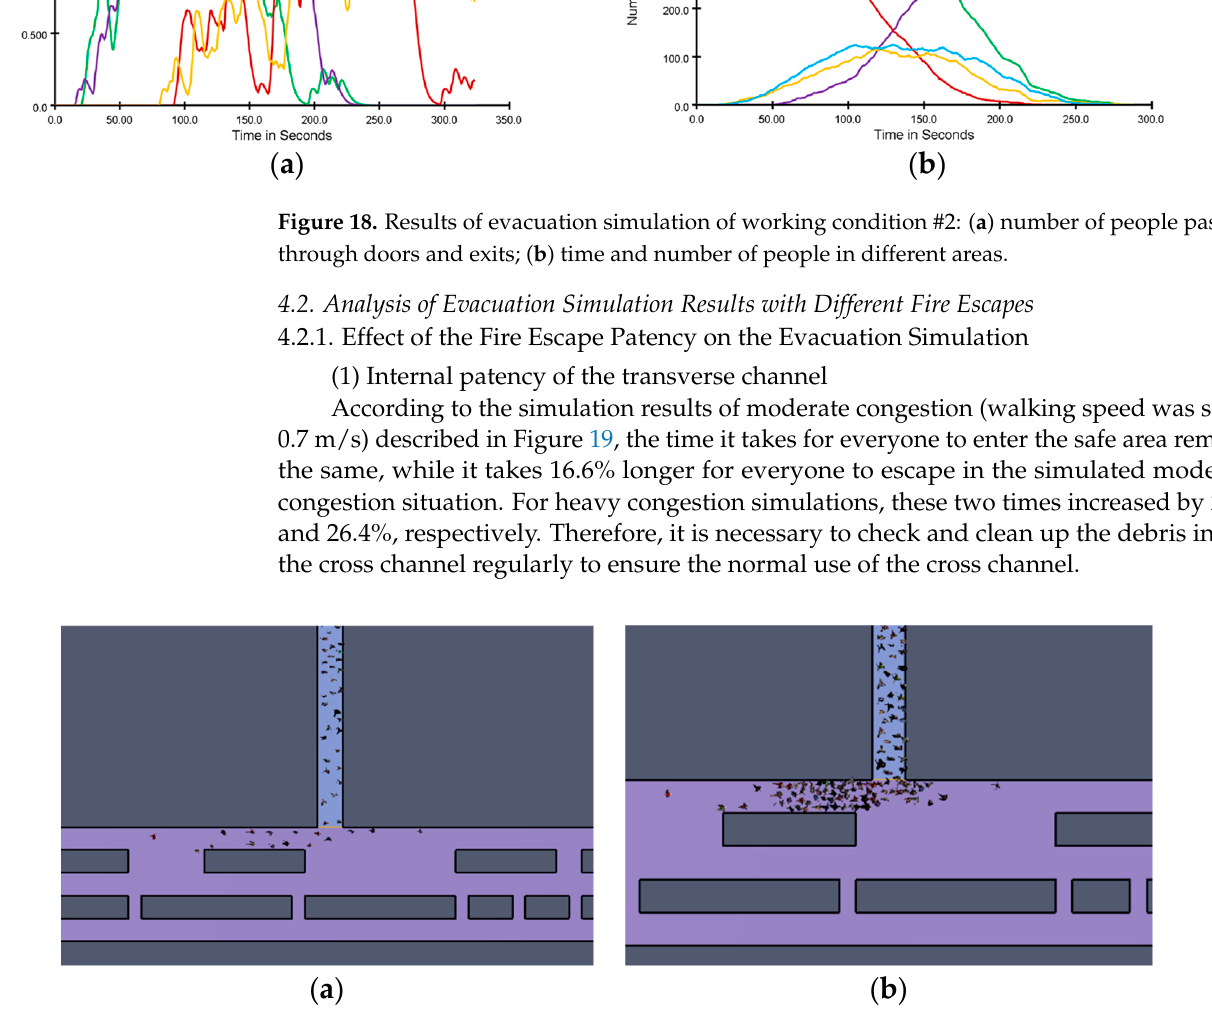
Figure 19. Situations inside the transverse passage: ( a ) moderate congestion; ( b ) heavy congestion.